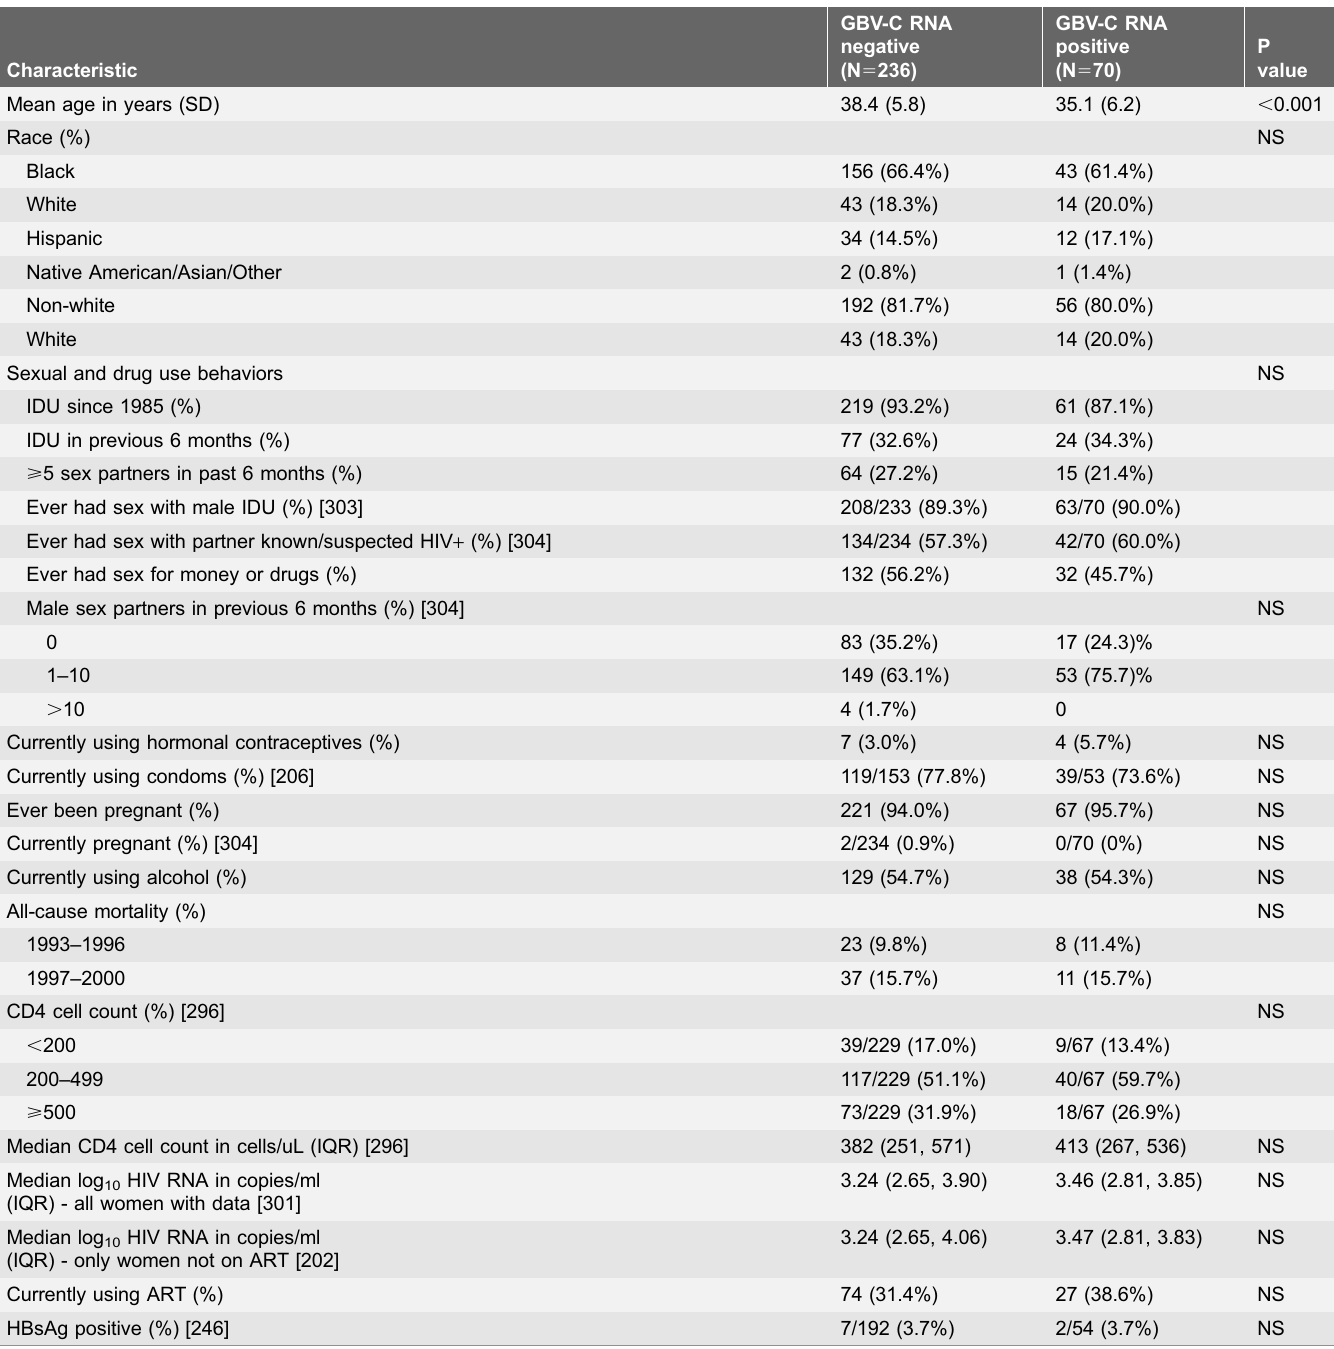
Table 2. Demographic and clinical data for 306 HIV-positive women from the HERS cohort included in the current